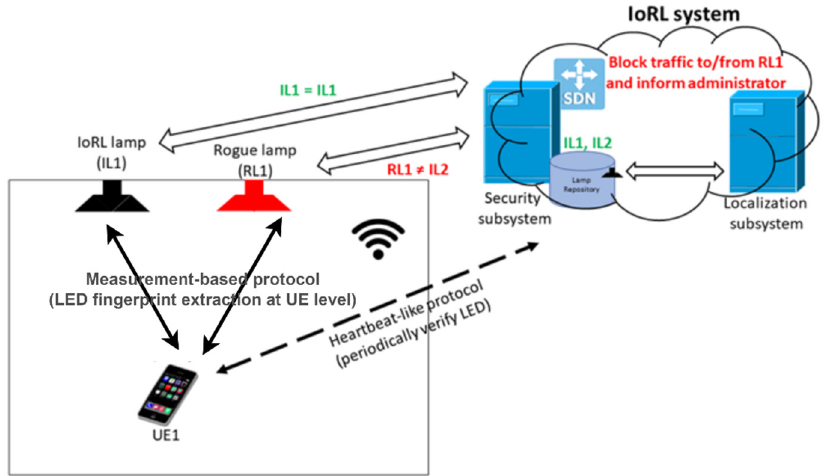
Figure 3. A block diagram of a typical 5G VLC multi-access scenario using the proposed security solution.